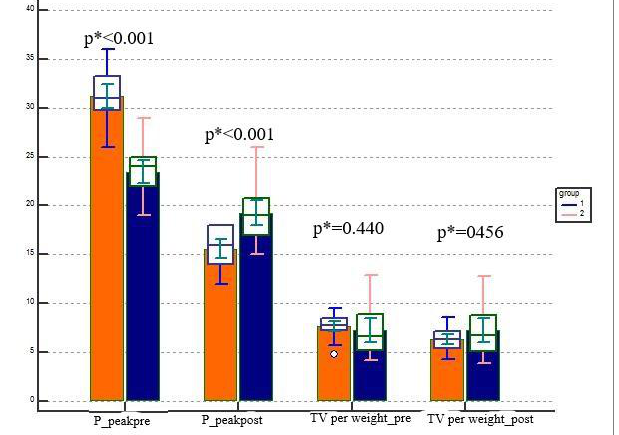
Figure 2: The changes of the plateau pressure and tidal volume per predicted body weight (ml/kg) in the ECMO and non-ECMO groups were compared. Group 1 was representing ECMO group while group 2 was representing non-ECMO group. ECMO: Extracorporeal membrane oxygenation; P_peakpre: plateau pressure just before ECMO/after surgery; P_peakpost: plateau pressure in the third day after ECMO/the day before extubation; TV per weight_pre: tidal volume per predicted body weight (ml/kg) just before ECMO/after surgery; TV per weight_post: tidal volume per predicted body weight (ml/kg) in the third day after ECMO/the day before